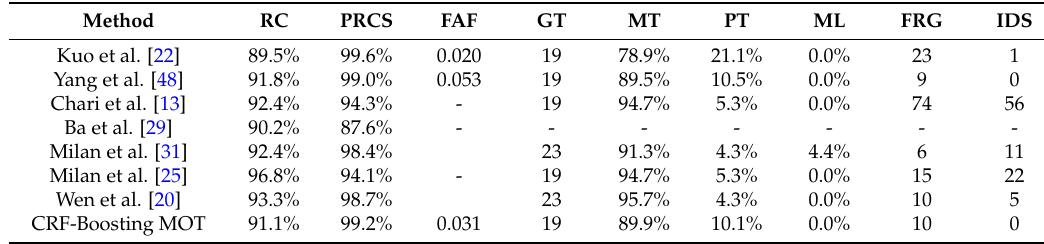
Table 4. Performance evaluation on PETS.